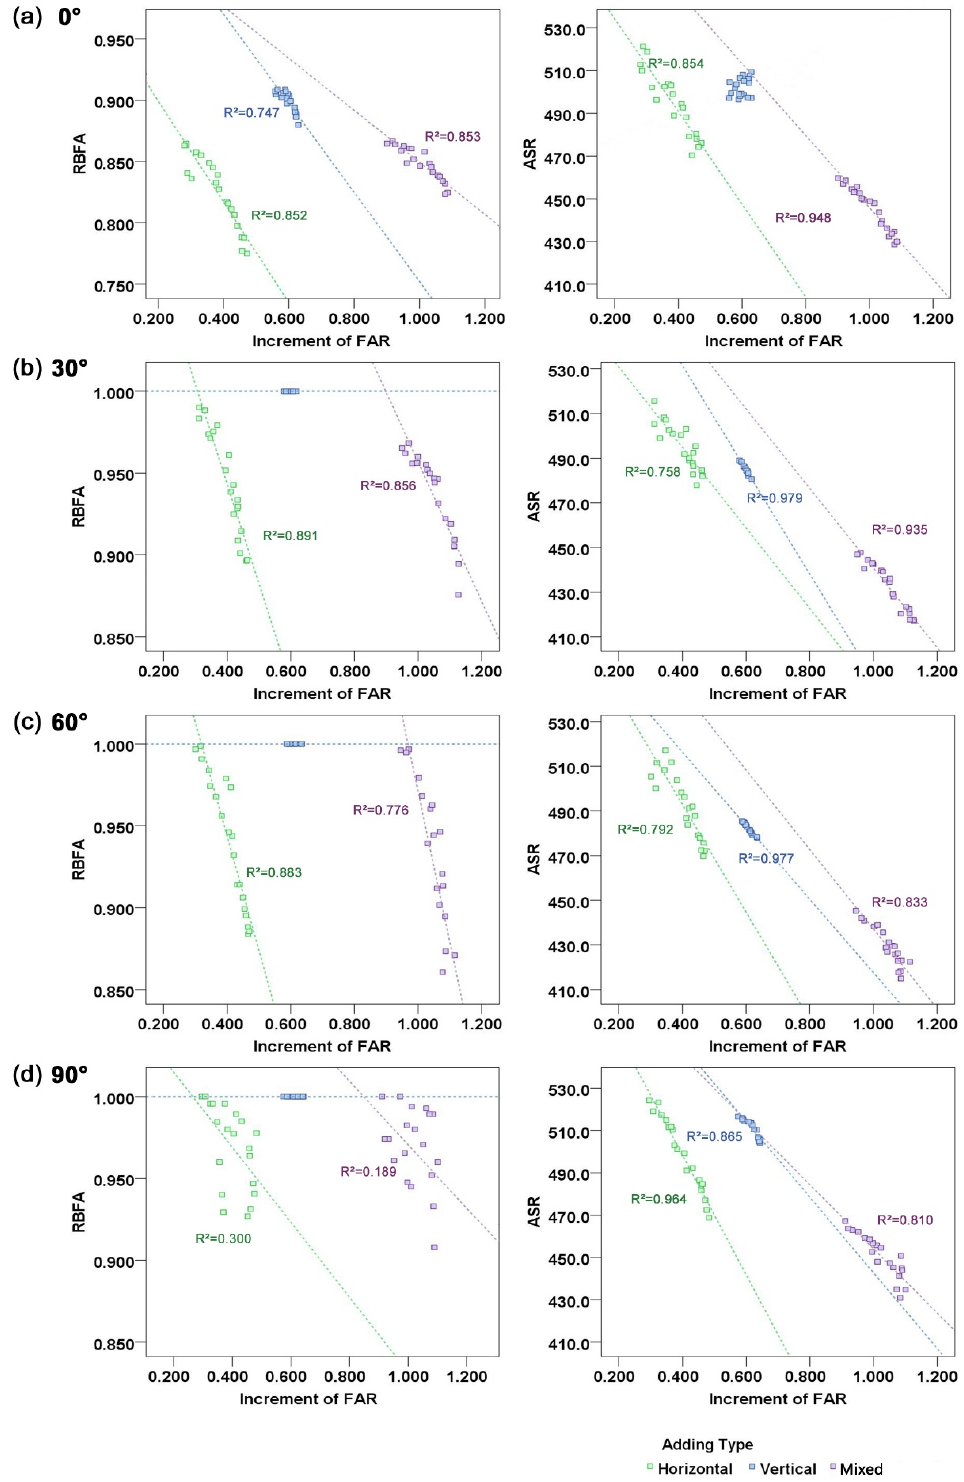
Figure 15. Correlation between increase in FAR and solar performance. ( a ) Orientation south, ( b ) orientation 30 ◦ south to east, ( c ) orientation 60 ◦ south to east, ( d ) orientation